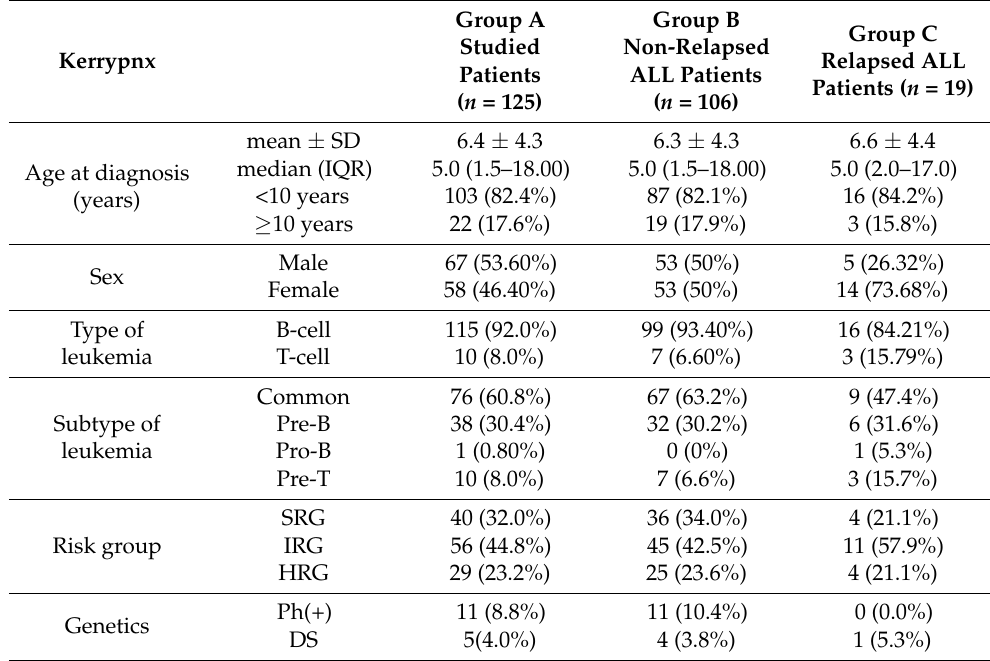
Table 1. The clinical characteristic comparing the three selected groups with acute lymphoblastic leukemia.